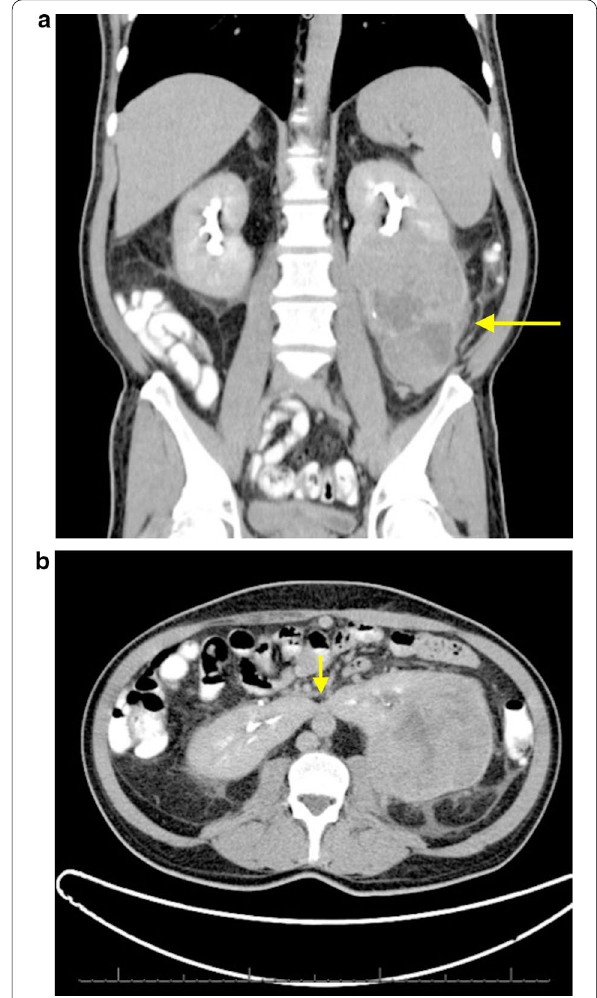
Fig. 1 a Coronal CT image showing large left lower moiety kidney tumor (yellow arrow). b Axial CT image showing horseshoe kidney with isthmus (yellow arrow) with left renal moiety